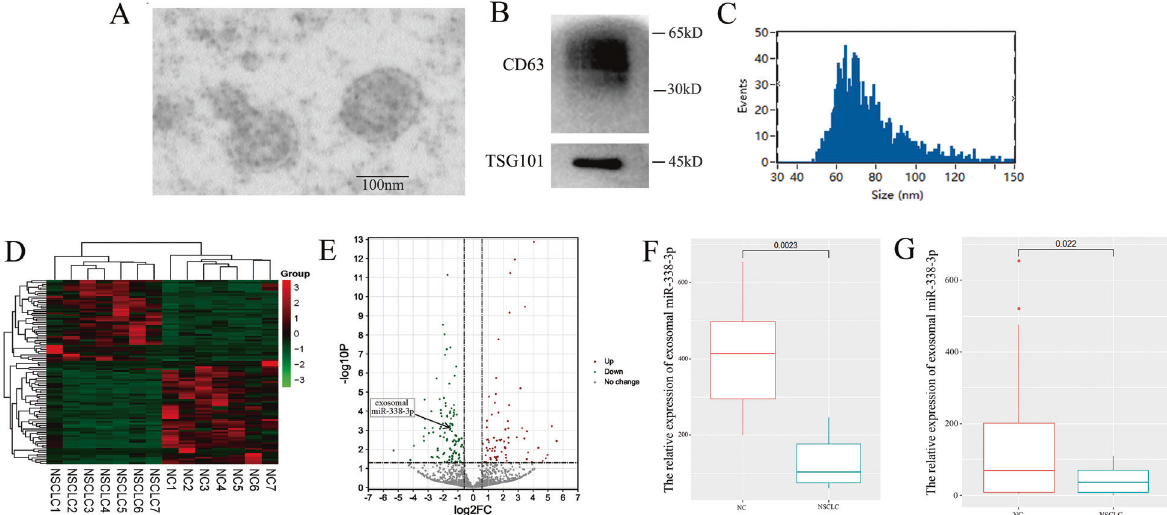
Fig. 5 Exosomal miR-338-3p is signi fi cantly enriched in healthy controls serums. A The transmission electron microscope result of serum- derived exosomes. B The western blotting results of exosome biomarkers, CD63 and TSG101. C The nanoparticle tracking analysis of exosomes. D The heatmap of the high-throughput sequencing of serum-derived exosomes miRNAs. E The volcano plot of expression levels of serum-derived exosomes miRNAs. F The expression of exosomal miR-338-3p in 14 sample serums. G The expression of exosomal miR-338-3p in 66 samples of patients